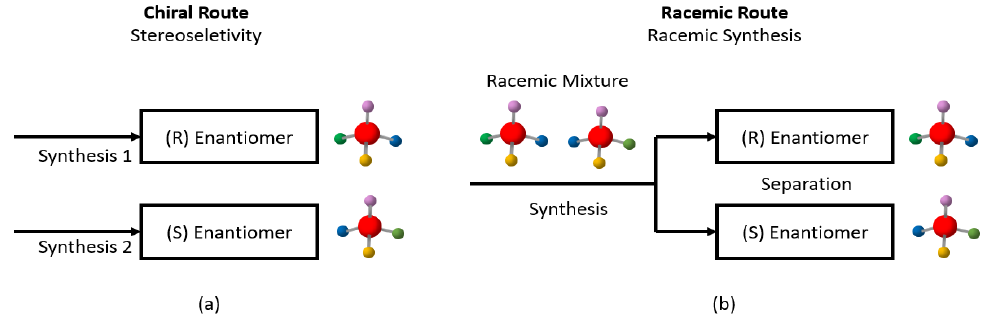
Figure 8. Enantiomers obtained by Chiral Route ( a ) Racemic Route ( b ).